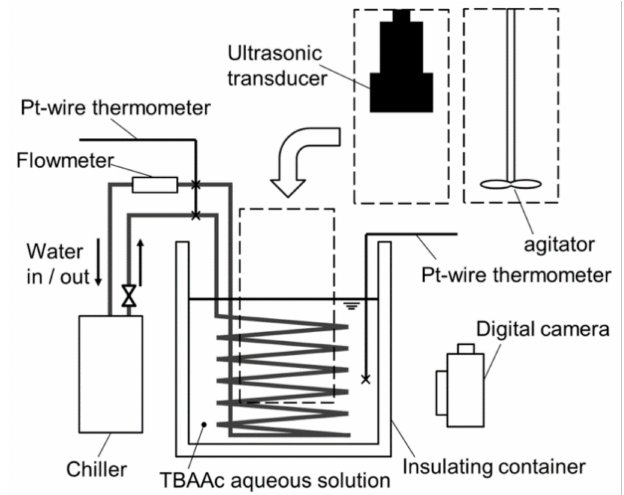
Figure 1. Schematic diagram of the